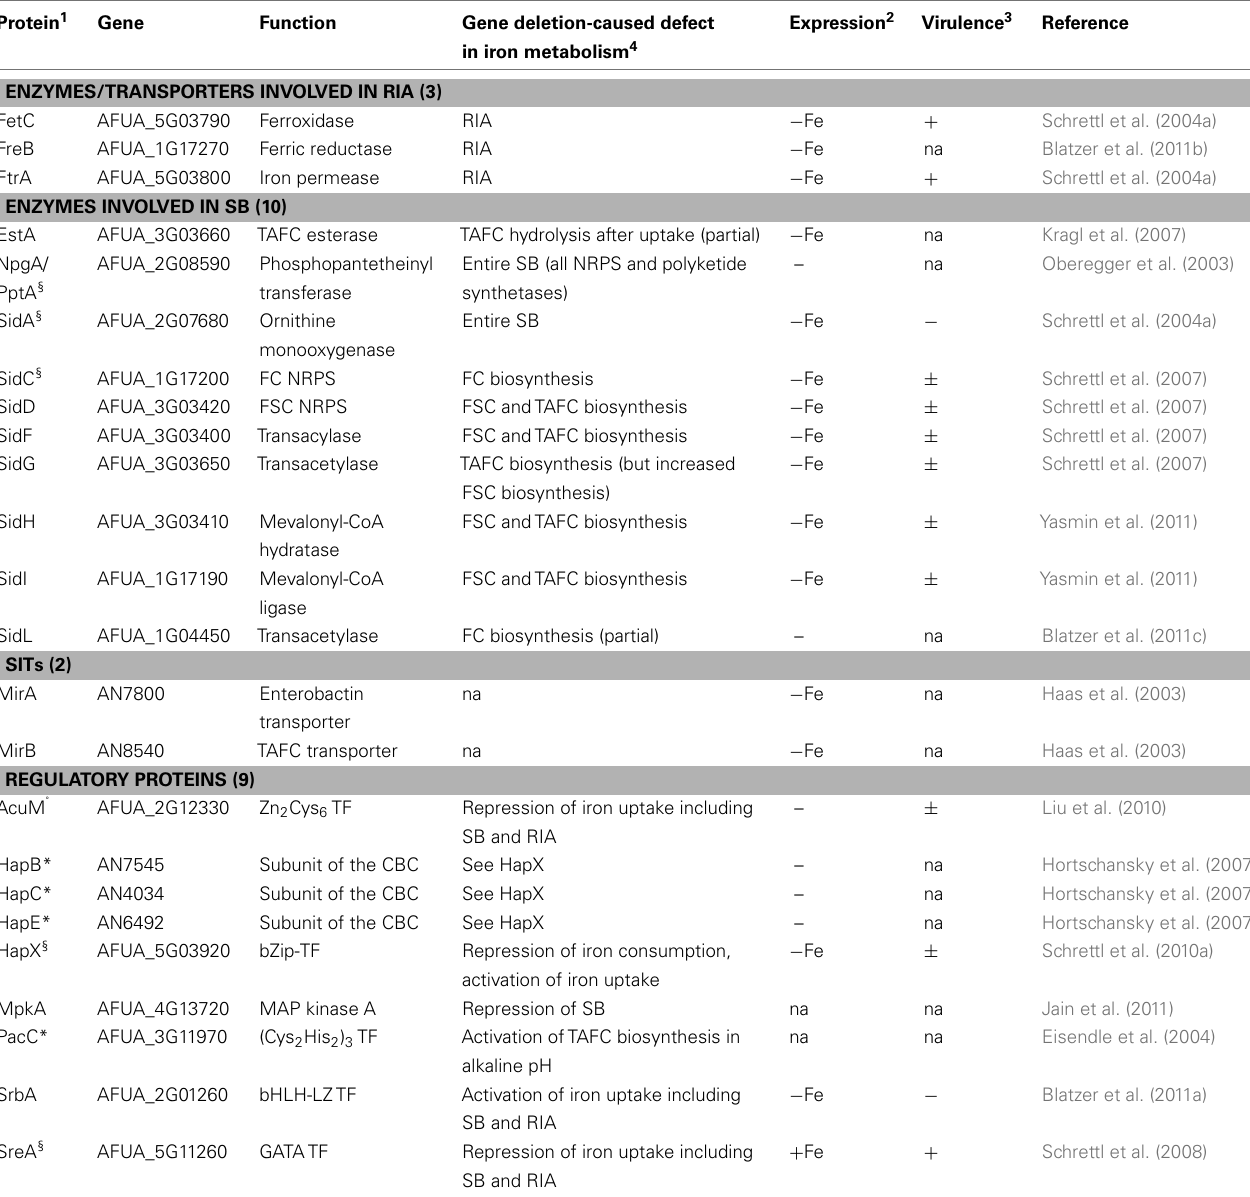
Table 1 | Functionally analyzed proteins involved in iron homeostasis in A. fumigatus and A. nidulans . Protein